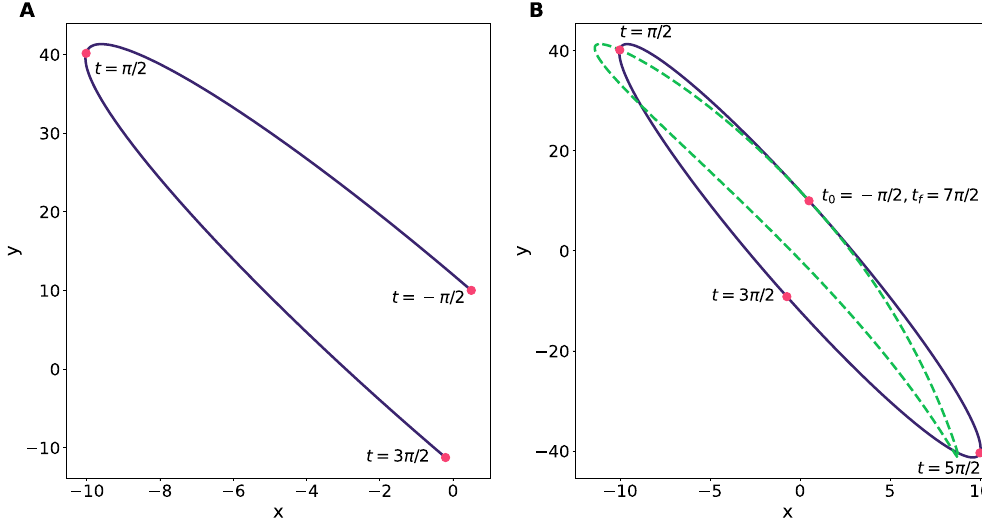
Figure 4. Semiclassical trajectories generated by the consecutive application of two polyharmonic pulses 1 , 10 5, 20 ) . ( A ) The ( of the type (Eq. 29) over a particle with initial conditions ( x , y ) and ( p x , p y ) 2 = = − π evolution process starts at t 0 2 in terms of a polyharmonic amplitude (Eq. 29) defined by the parameters = − (cid:30) (cid:31) π 2, c 3 finalising its application at t b 2 —where the amplitude vanishes. Immediately, at the very same = = = − 7 9 , c time, the evolution process continues its development now in terms of the pulse defined by b 5 2 that = − = 3 π (cid:31) 0.403 will end its application at t x = − 2 . The resulting operation attains a squeezing transformation with = 1.125 . ( B ) To invert the operation and recover the initial observables’s values, the second pulse has and (cid:31) y = − 3 π 5 π to be applied once again from t 2 to t = 2 , where the evolution process is now conducted by the first pulse = 5 π 7 π during from t 2 to t = 2 . The dotted line represents the distorted evolution generated by the presence of = an external harmonic force sin ( t ) in the direction Ox , even though note the original configuration is entirely recovered by reversing the